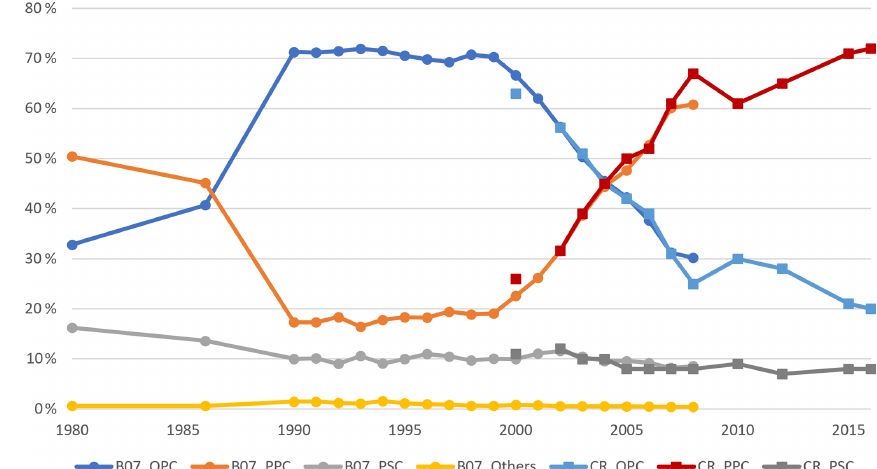
Figure C4. Proportions of cement production by type. B07: Bapata et al. (2007); CR: CRISIL (Cement Industry Report, https://www.crisil. com/, last access: 31 March 2017). OPC: Ordinary Portland cement; PPC: Portland pozzolana cement; PSC: Portland slag cement.